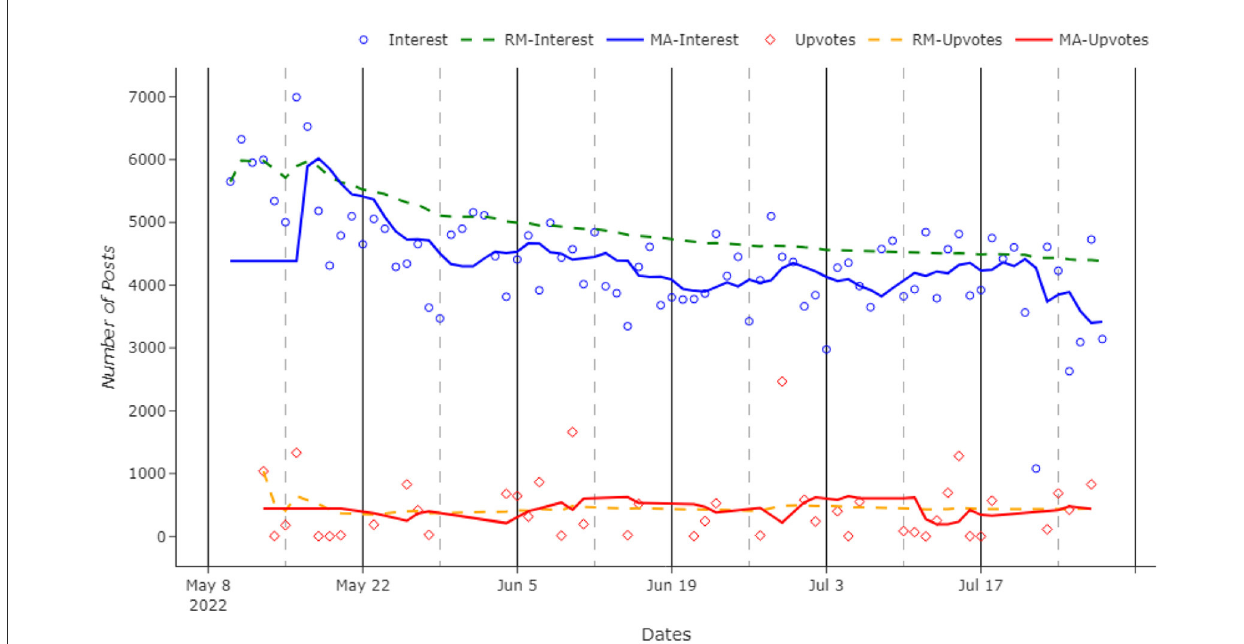
FIGURE2 Number of submissions and daily average number of upvotes over time. The acronyms in the figure legend are: RM stands for the running mean, whilst MA is the moving average.